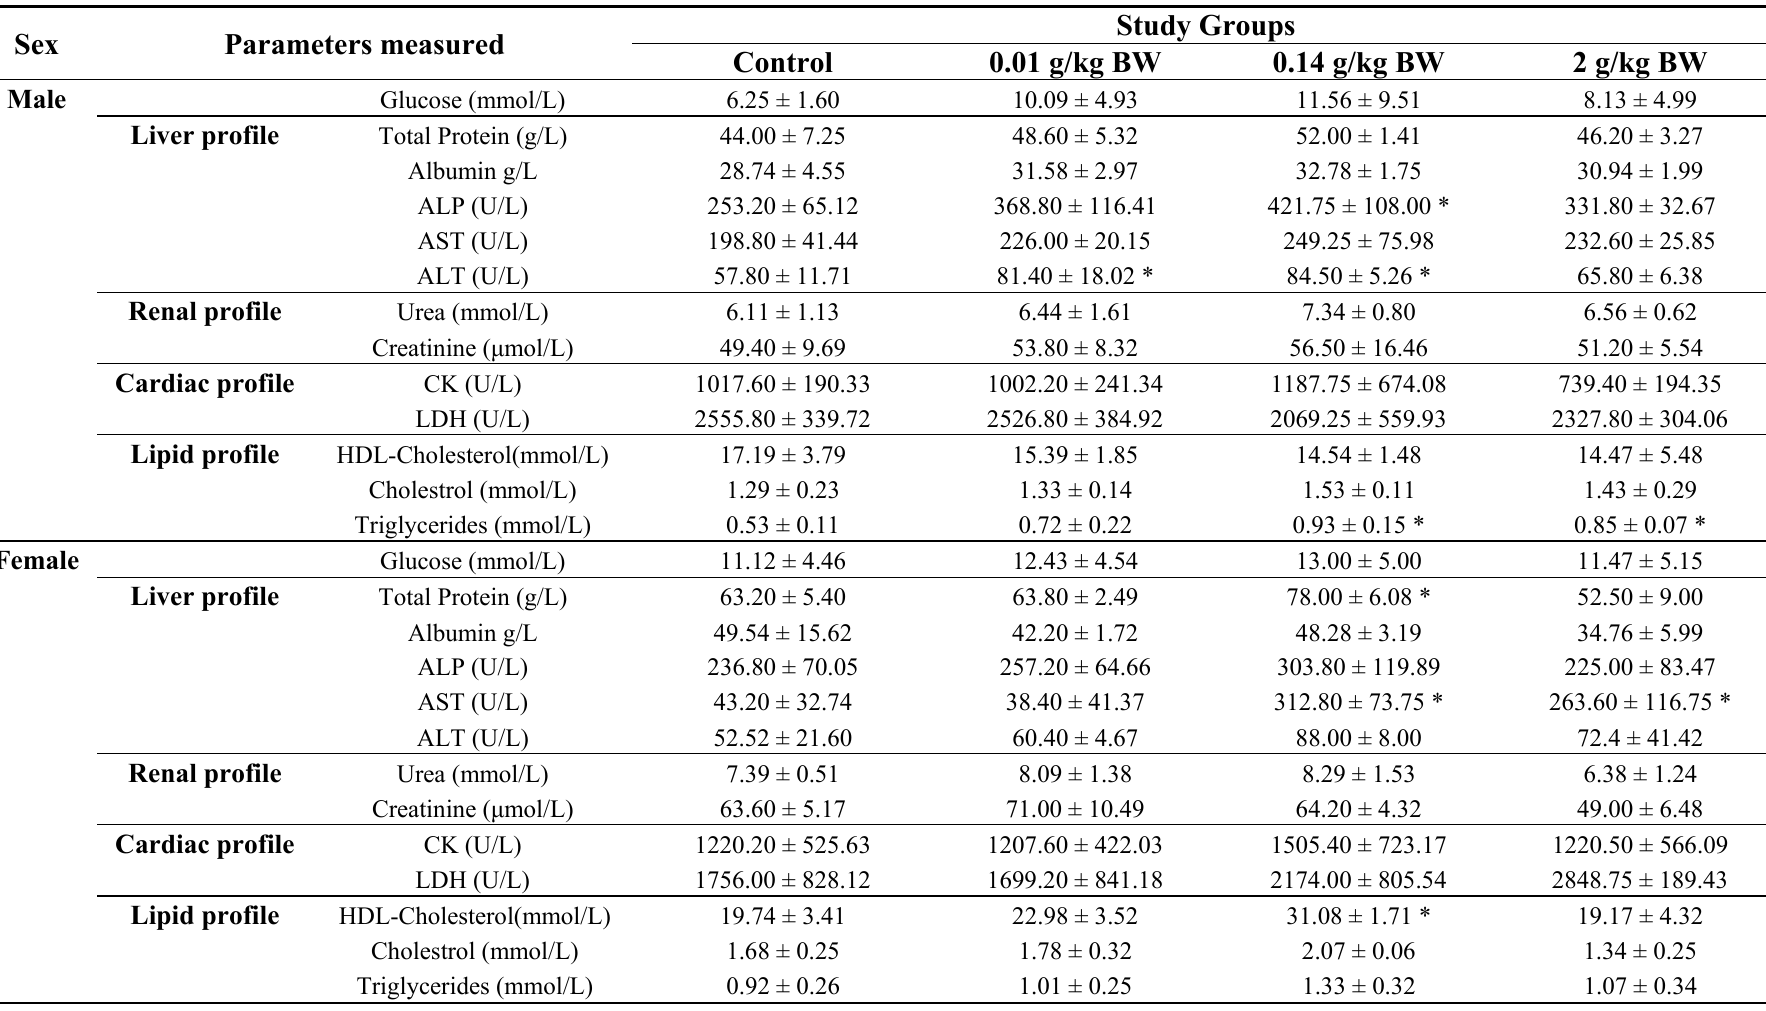
Table 3. Clinical biochemistry findings from male and female study group, the control and rats treated with C. papaya leaf extracts measured during the 28 Days sub-acute toxicity study. The Clinical biochemistry data was measured by Vitalab Selecta, E-series,